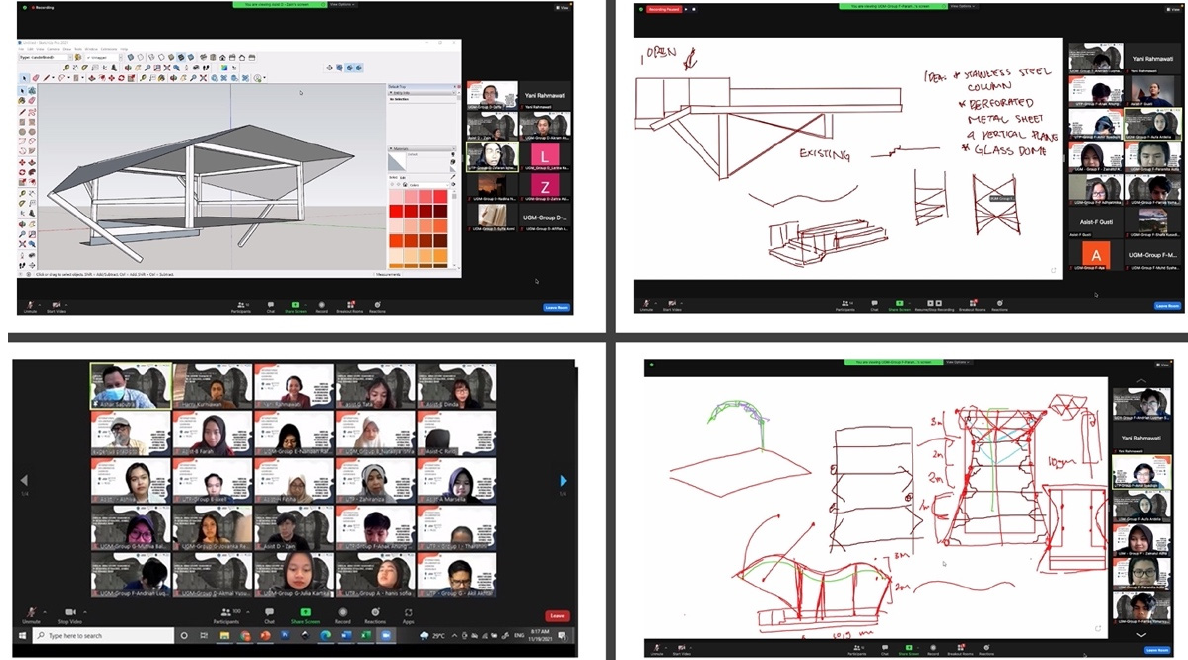
Figure 3. Photos of collaborative learning process during workshop on day one.